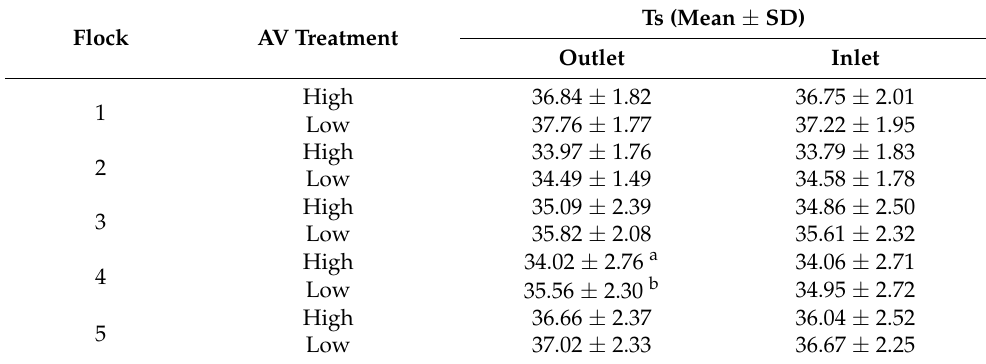
Table 10. Difference in surface temperatures at the inlets and outlets of the